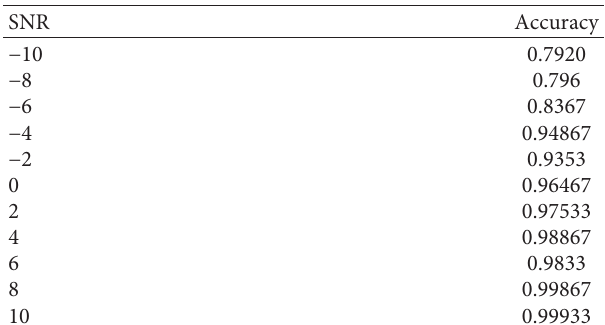
Table 3: The accuracy of different SNRs.